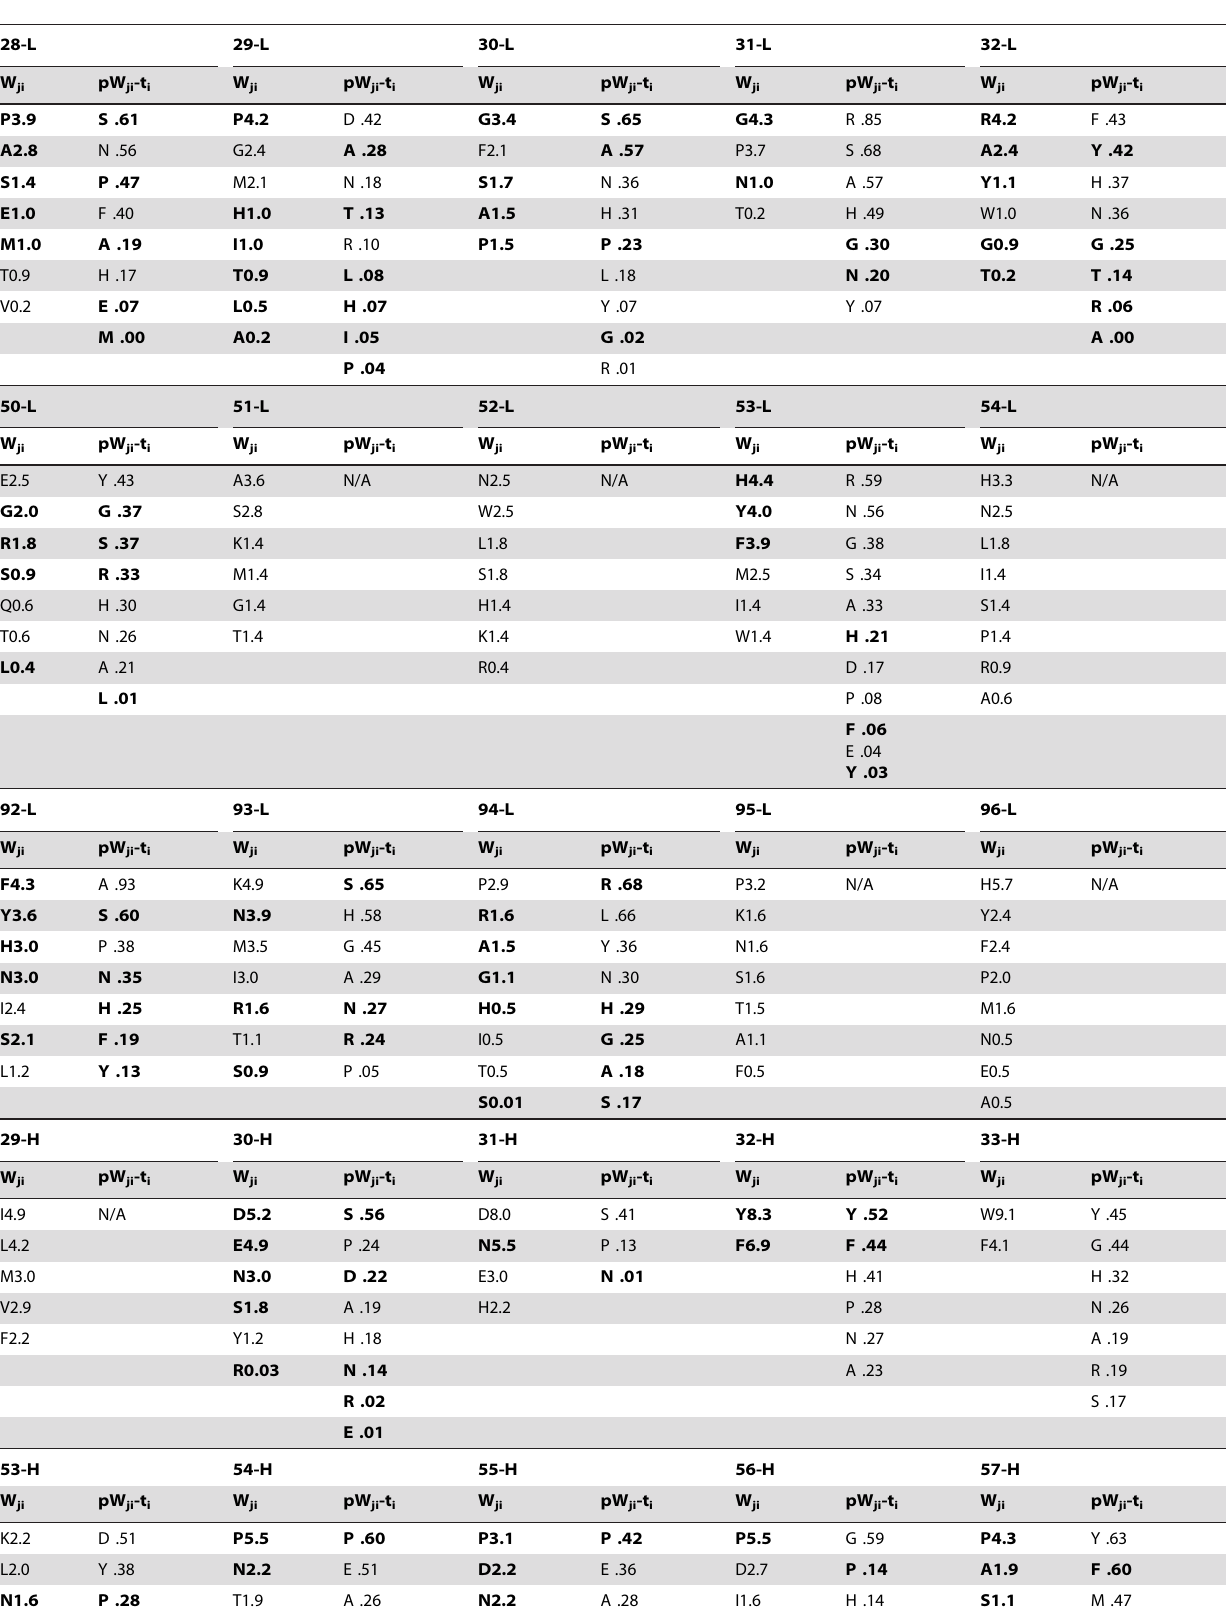
Table 1. Comparison of the predicted and the experimental amino acid preferences at each of the CDR interface positions.